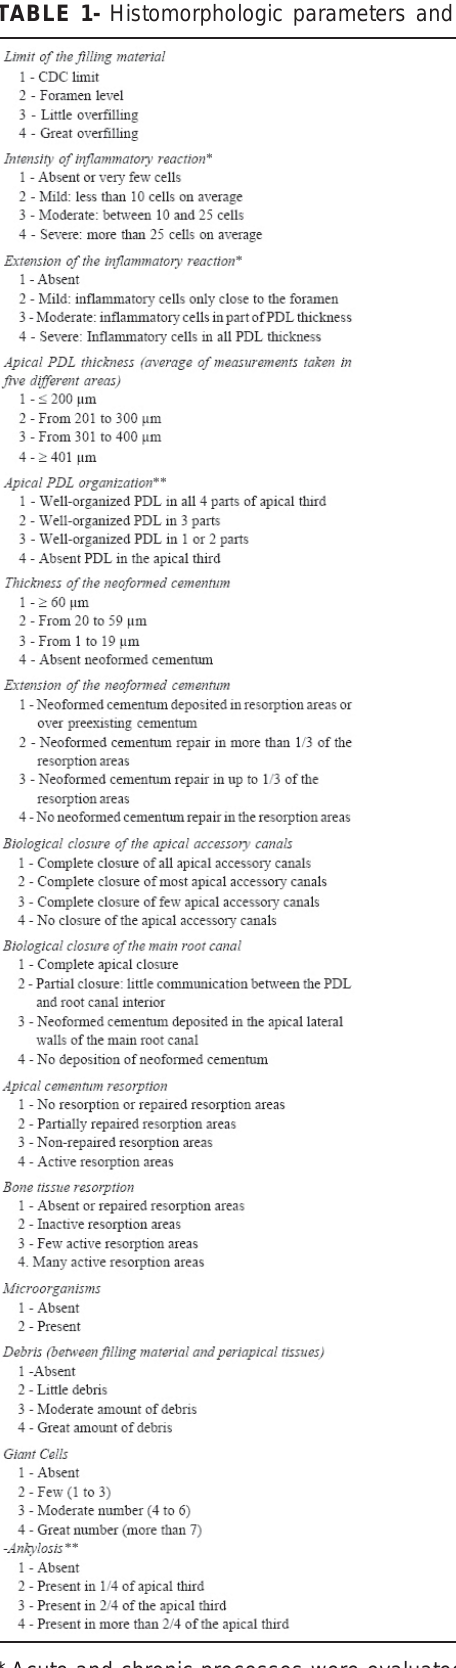
FIGURE 2- Group II – Calcium hydroxide – Presence of newly formed cement with repair of the areas of resorption and a discrete chronic inflammatory infiltrate. H.E.,